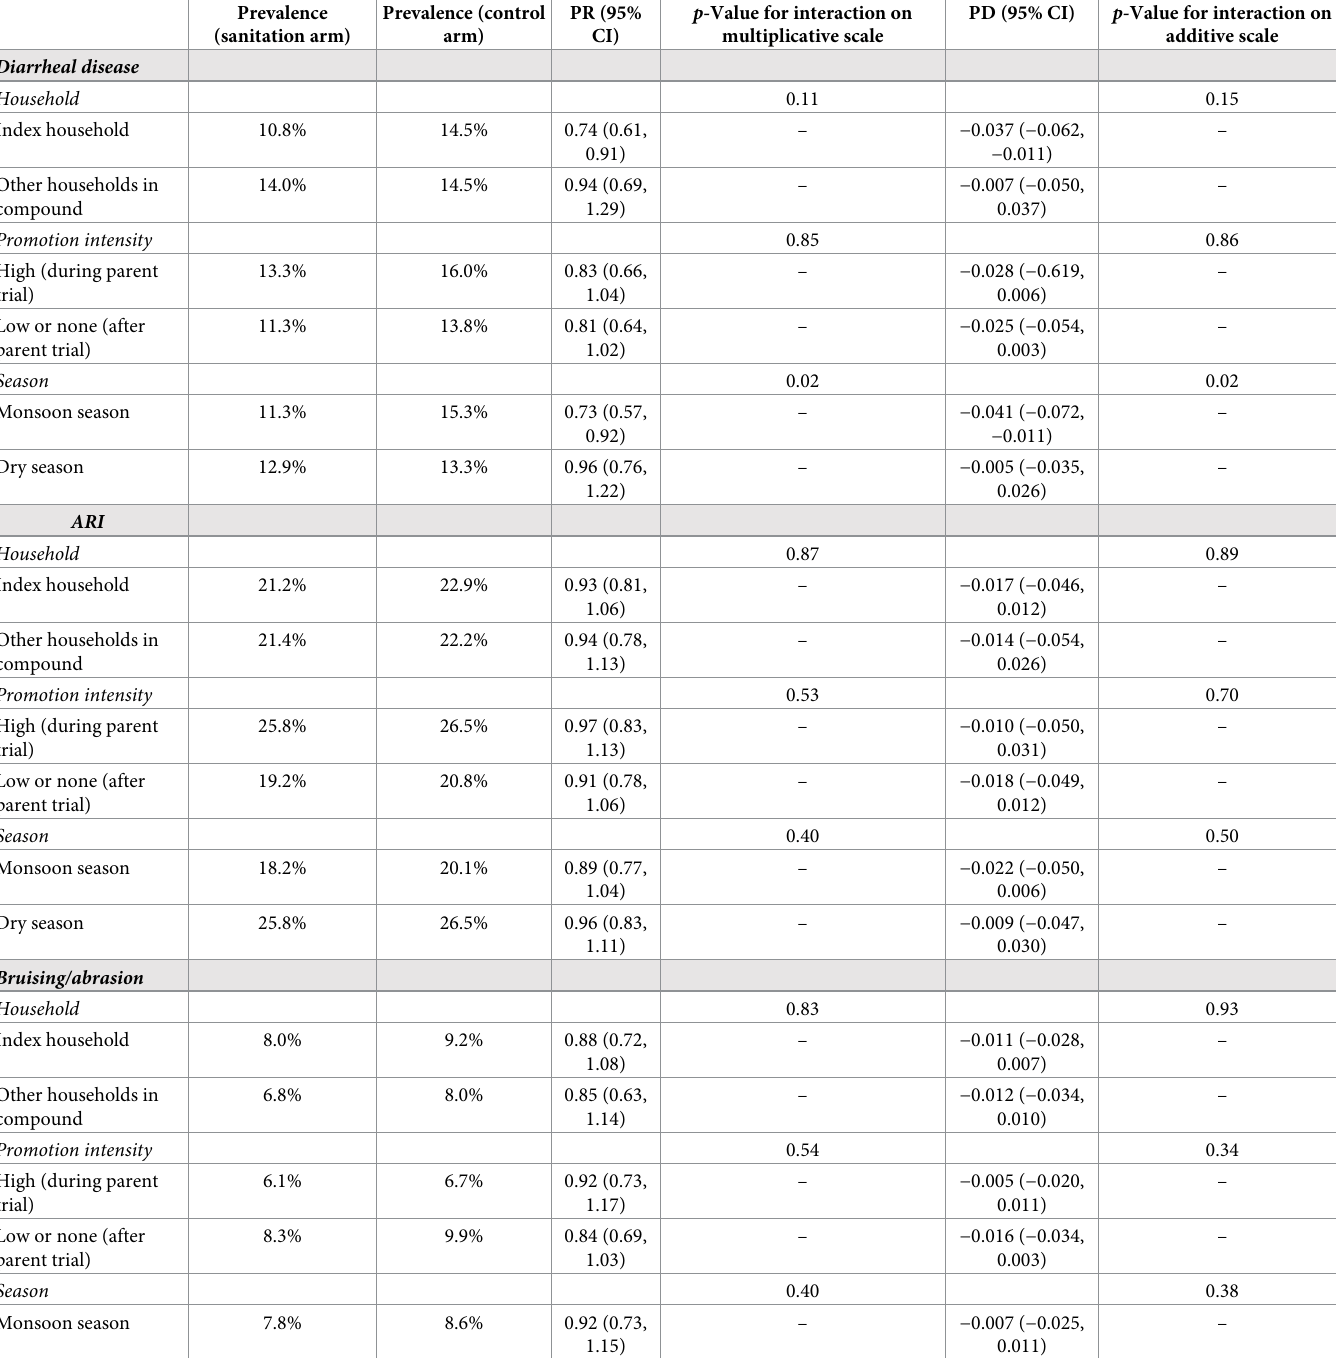
Table 2. Effect modification by household of residence (children living in index household a vs. in other households within compound), periods of high-intensity vs. low-intensity or no promotion (during vs. after parent trial completion), and season (monsoon vs.